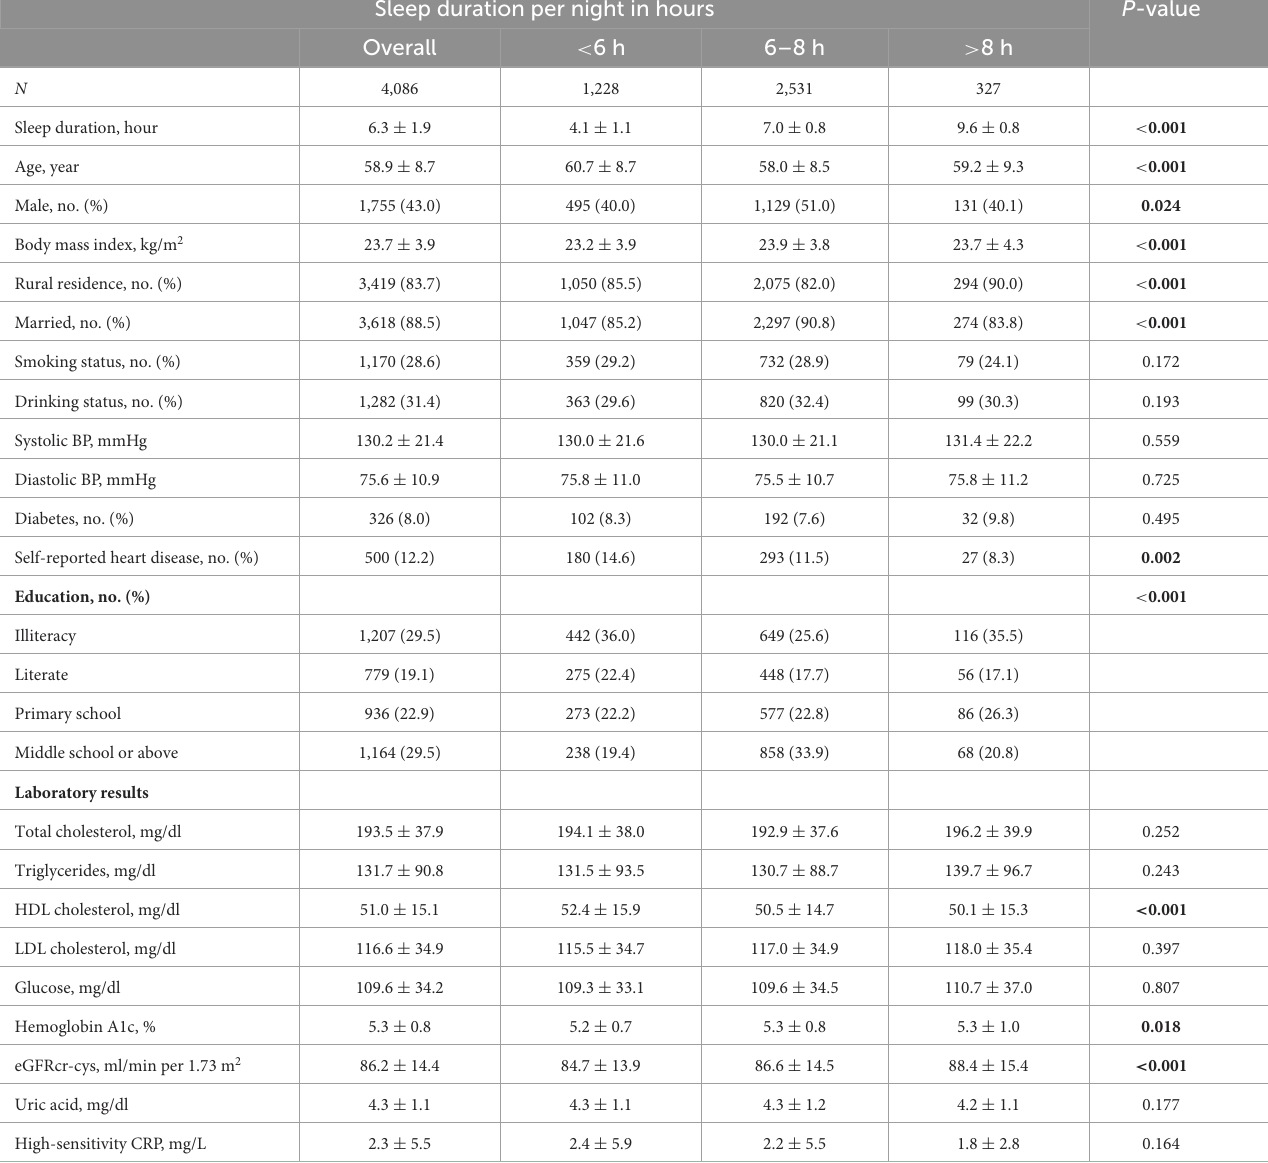
TABLE 1 Participants ( n = 4,086) characteristics by night sleep duration categories. Sleep duration per night in hours P -value Overall < 6